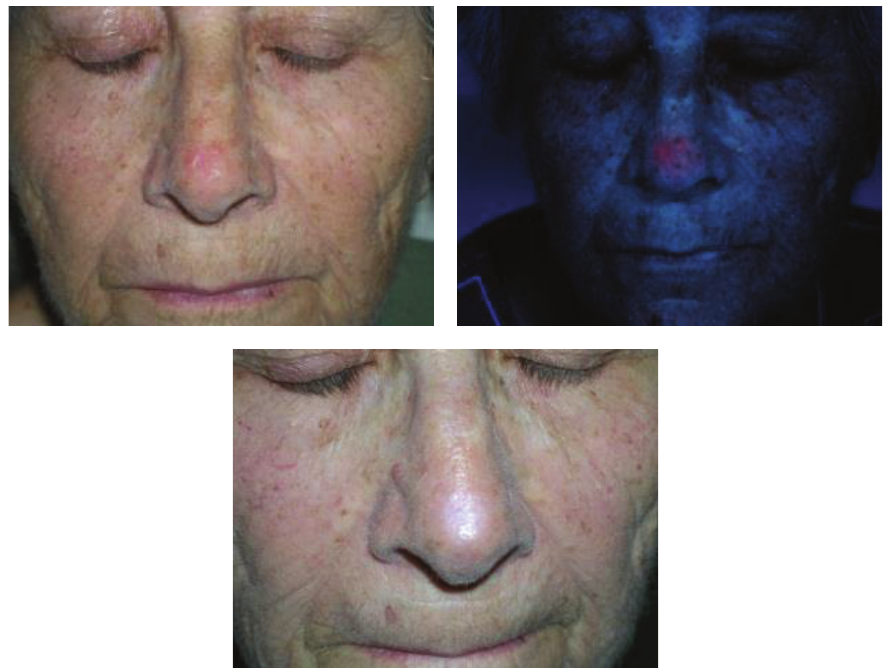
Figure 3: Superficial BCC in the nose. Inexact fluorescence and complete response (24 months).